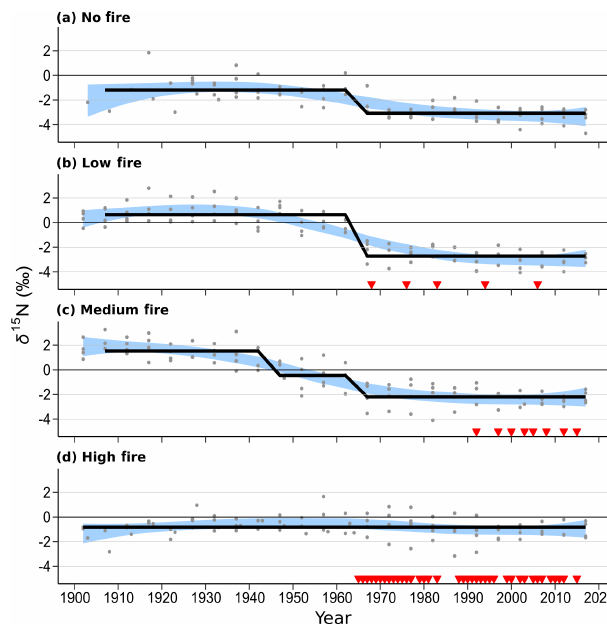
Figure 5. Wood δ 15 N patterns of mature Quercus trees in each of the four burn stands. Four trees were sampled in each stand. Blue shaded areas represent the 99% confidence intervals of a LOWESS curve fit, and the thick black line shows mean δ 15 N states deter- mined using regime-shift analysis. Red triangles indicate individual years of prescribed fire in each treatment stand. Mid-20th-century declines in wood δ 15 N are readily seen in the no-fire, low-fire, and medium-fire